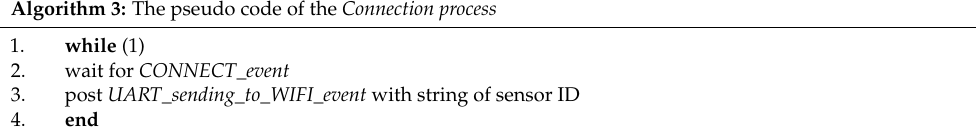
Algorithm 3: The pseudo code of the Connection process